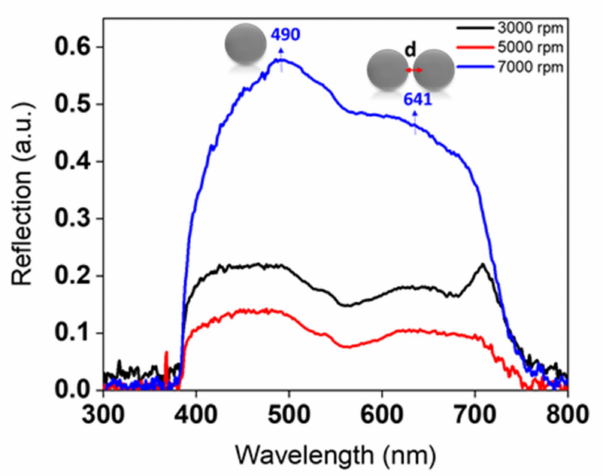
Figure 4. Reflection spectrum of AgNPs/PMMA nanocomposites prepared with different spin- coating speeds. The spectra were extracted using a bright-field optical